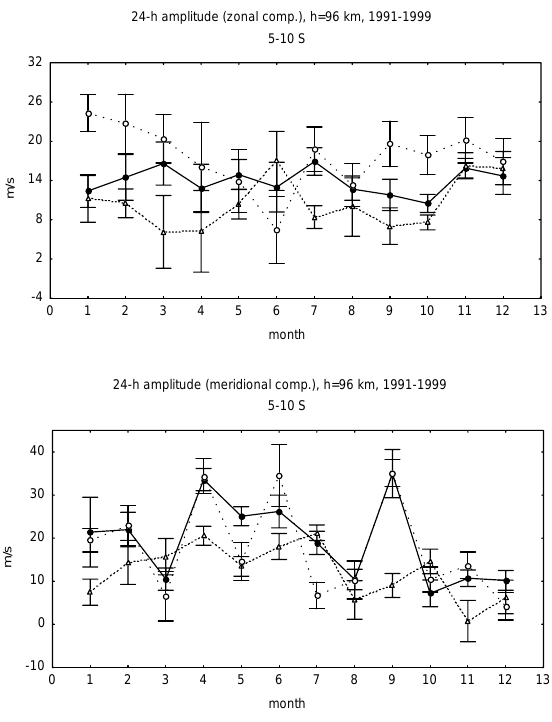
Fig. 16. Climatic seasonal variations of the prevailing zonal (top) and meridional (bottom) wind components at 96km during 1991– 1999 as seen by HRDI and by the meteor radar at Jakarta. Filled circles: HRDI data for the 5 ◦ –10 ◦ S latitude belt, averaged over all longitudes. Open circles: HRDI data for the 62 ◦ –152 ◦ E longitude sector. Open triangles: Jakarta data (6 ◦ S, 107 ◦ E). Vertical bars represent one standard deviation.